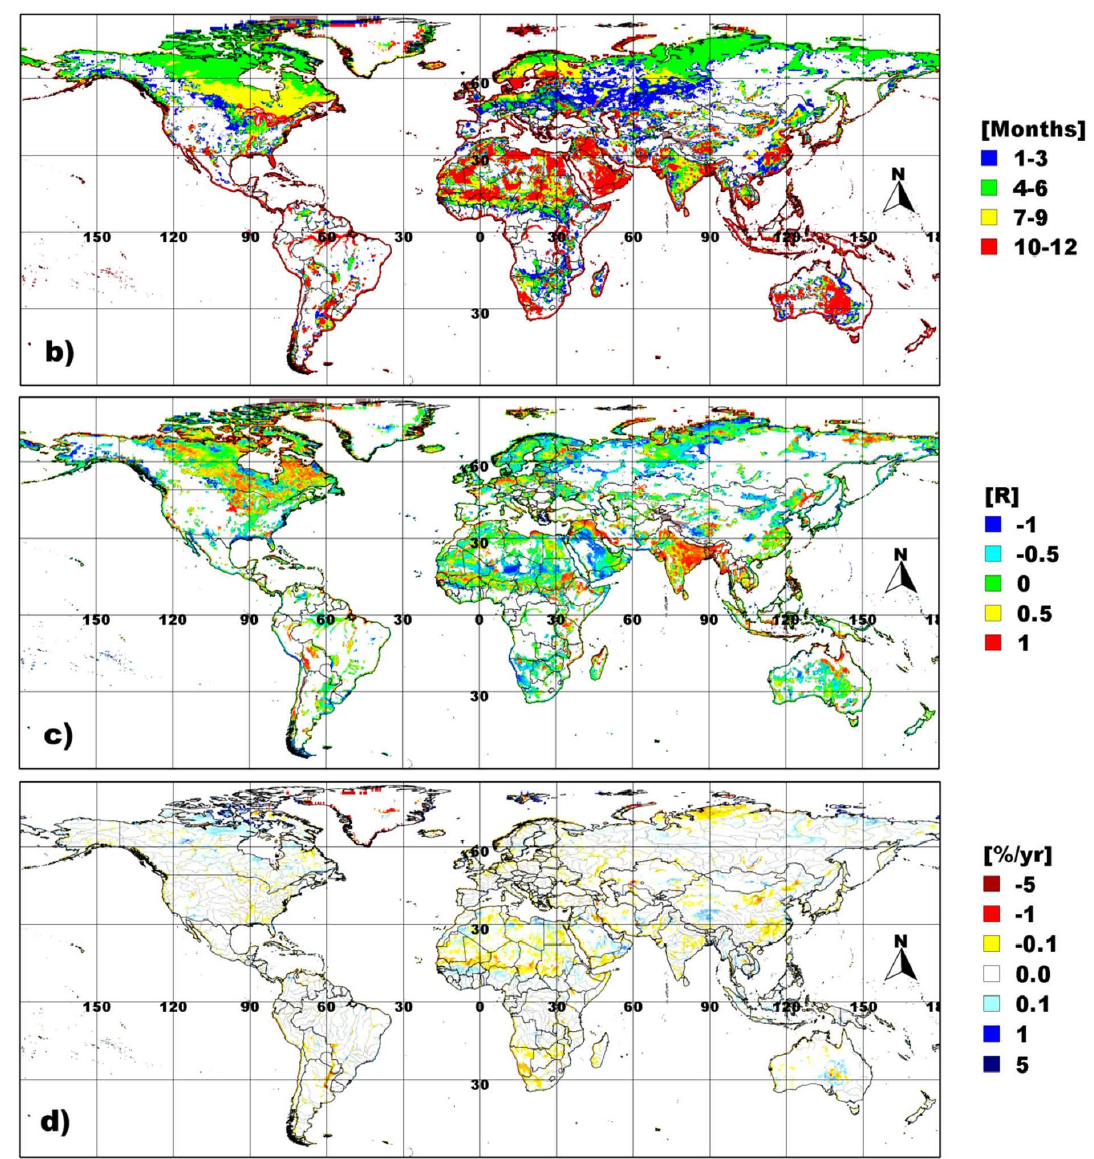
Figure 6. Global maps of: ( a ) the month of average maximum fractional water (FW); ( b ) the average number of inundated months; ( c ) the temporal linear correlation (R) between FW and the Modern-Era Retrospective Analysis for Research and Application (MERRA) precipitation analysis and ( d ) the trend of the annual FW means over the global domain as determine from combined, v1-ERS (1992–1999) and v1-QSCAT (2000–2008) monthly means and total monthly precipitation from the MERRA reanalysis (1992–2008). Actual figure color (c,d) is a linear interpolation of the colors in the legend. Except for (d), areas in white are outside of the domain or are screened (annual mean FW < 1%) from the analysis, while areas in dark grey represent snow covered regions. The annual FW trend was approximated from the slope of the least-square best fit-line and trend significance was assessed at a minimum 95% ( p < 0.05) probability level. Only statically significant trends are shown. Map projection same as Figure 2. Distance covered by one degree of latitude is approximately 111-km.